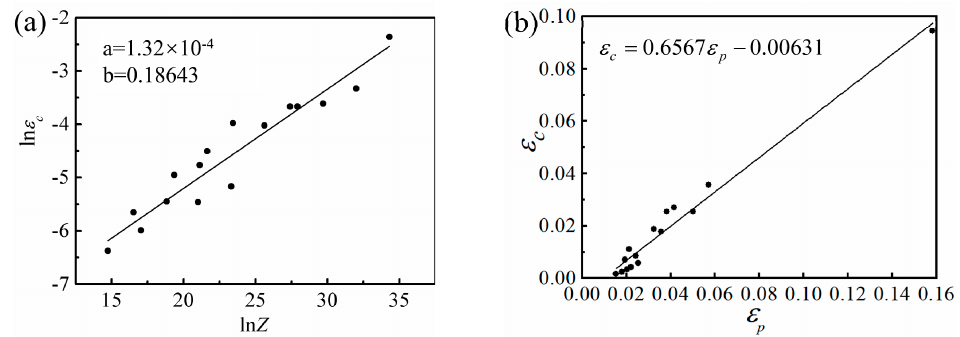
Figure 15. ln ε c -ln Z relationship curve ( a ) and ε p – ε c relationship curve ( b ).